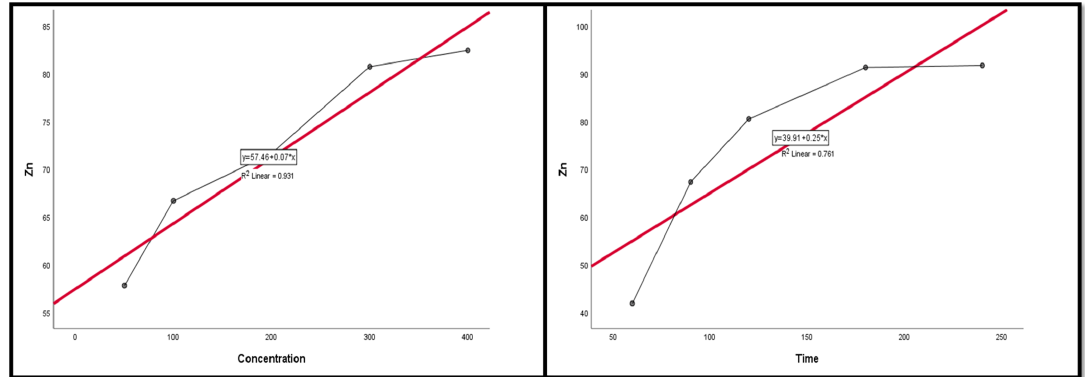
Figure 13. The scatter plot with linear regression fit for Zn leaching efficiency, %, and factors.